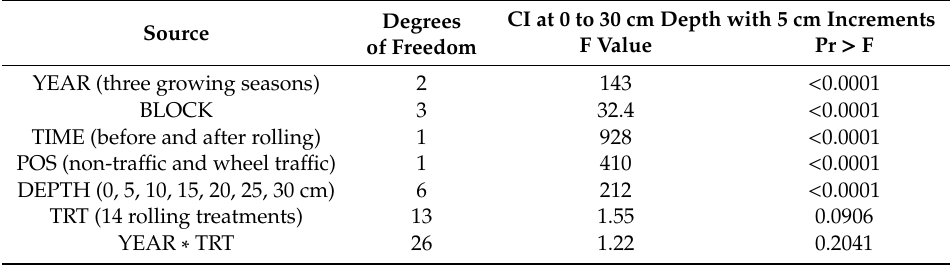
Table 10. Analysis of variance for cone index (CI) for 7 depths from 0 to 30 cm with 5 cm increments during 2015–2017 growing